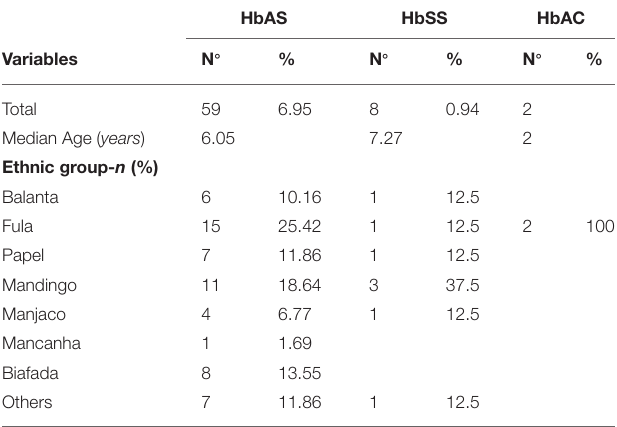
TABLE 3 | Distribution of abnormal hemoglobin in the different ethnic groups. HbAS HbSS HbAC